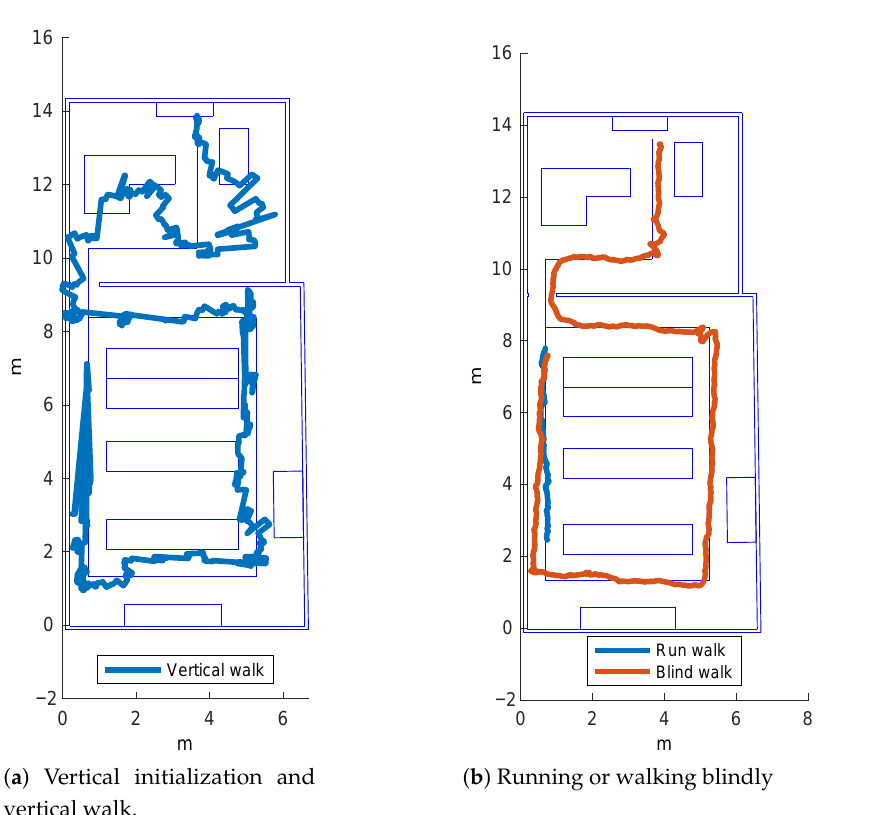
Figure 7. Tracking performance in ARIANNA+ with vertical initialization and walk, running or walking